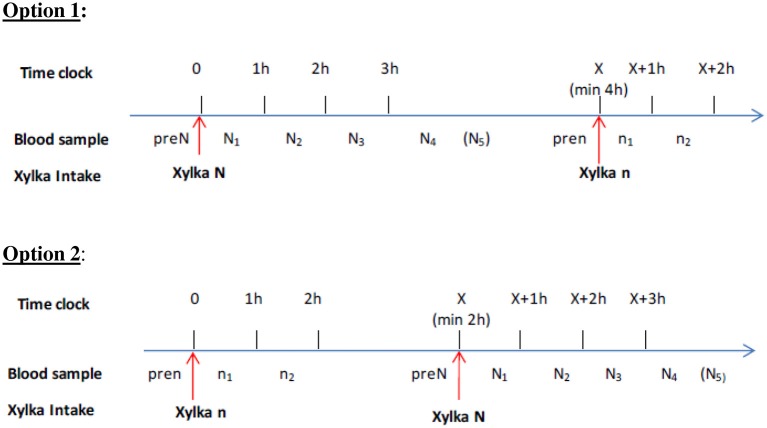
Types of PK sampling strategy, depending on the daily baclofen intake.